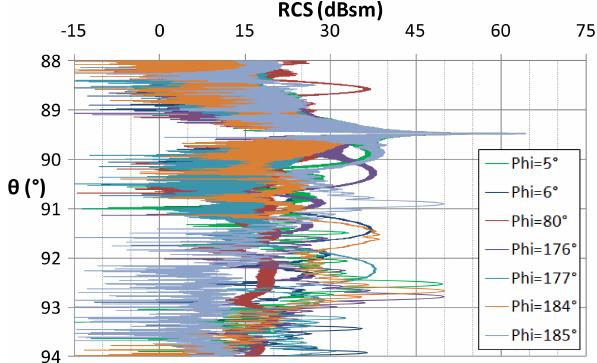
Figure 4. Vertical sections of RCS patterns ( φ = 5 ◦ ) for wind turbine models 1 to 3 at frequency 9.40GHz. Rotor position is indi- cated in the lowest right corner.